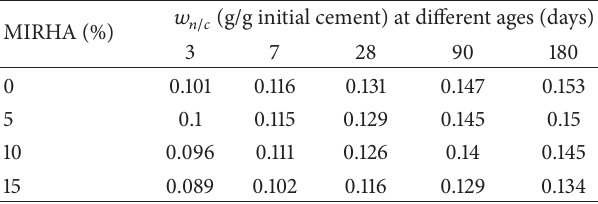
Table 6: Nonevaporable water content ( 𝑤 𝑛 ) by OD/FI. 𝑤 𝑛/𝑐 (g/g initial cement) at different ages (days) MIRHA (%) 3 7 28